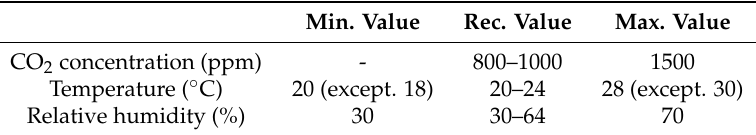
Table 1. Limit values of measured